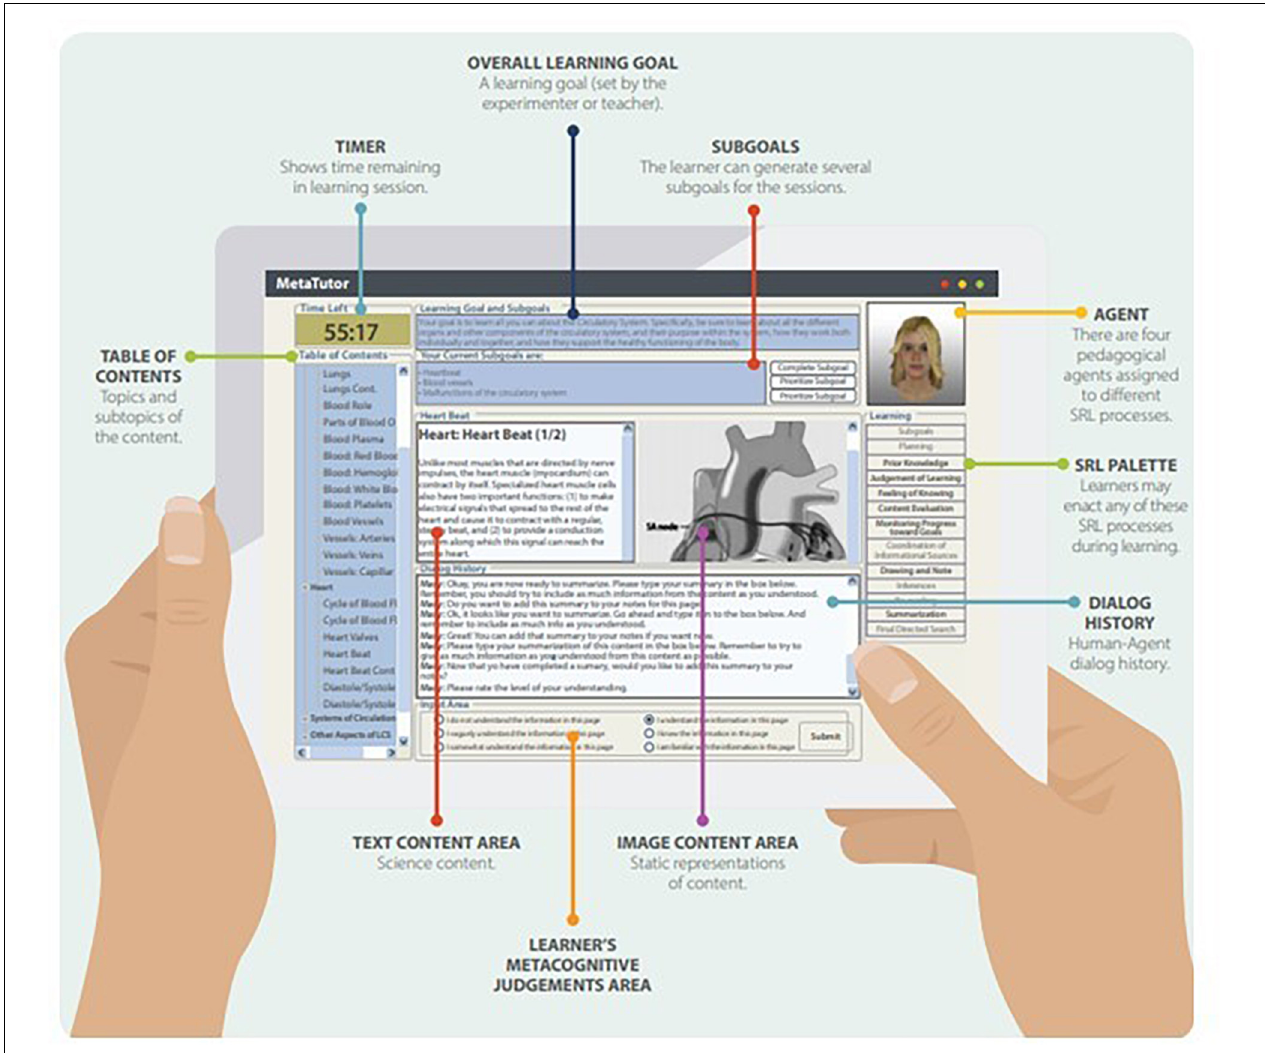
FIGURE 1 | MetaTutor’s main interface